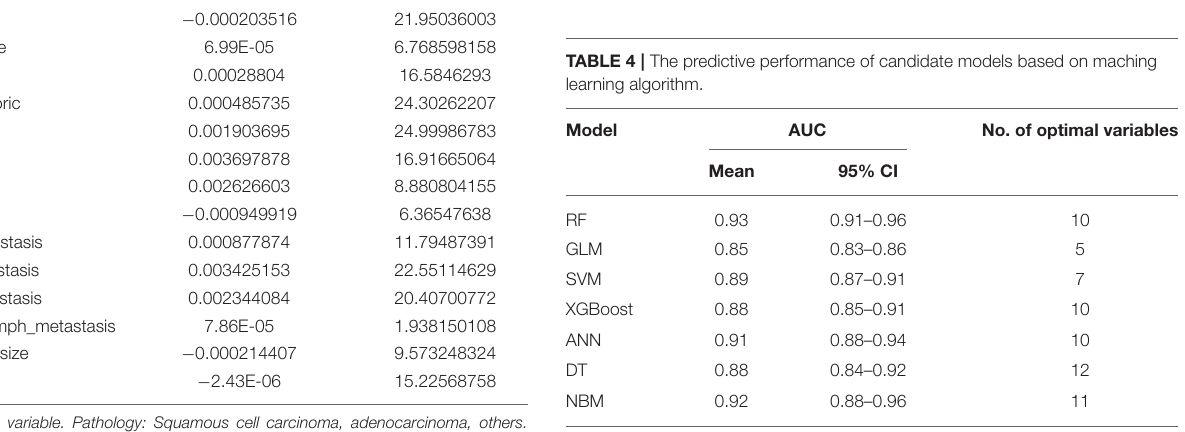
* Continuous variable. Pathology: Squamous cell carcinoma, adenocarcinoma, others. Primary_site: According to the primary site labeled (Cervix uteri, Endocervix, Exocervix, and Overlapping lesion of cervix uteri). TNM stage: tumor node metastasis classification (AJCC6th). AJCC, American Joint Committee on Cancer.